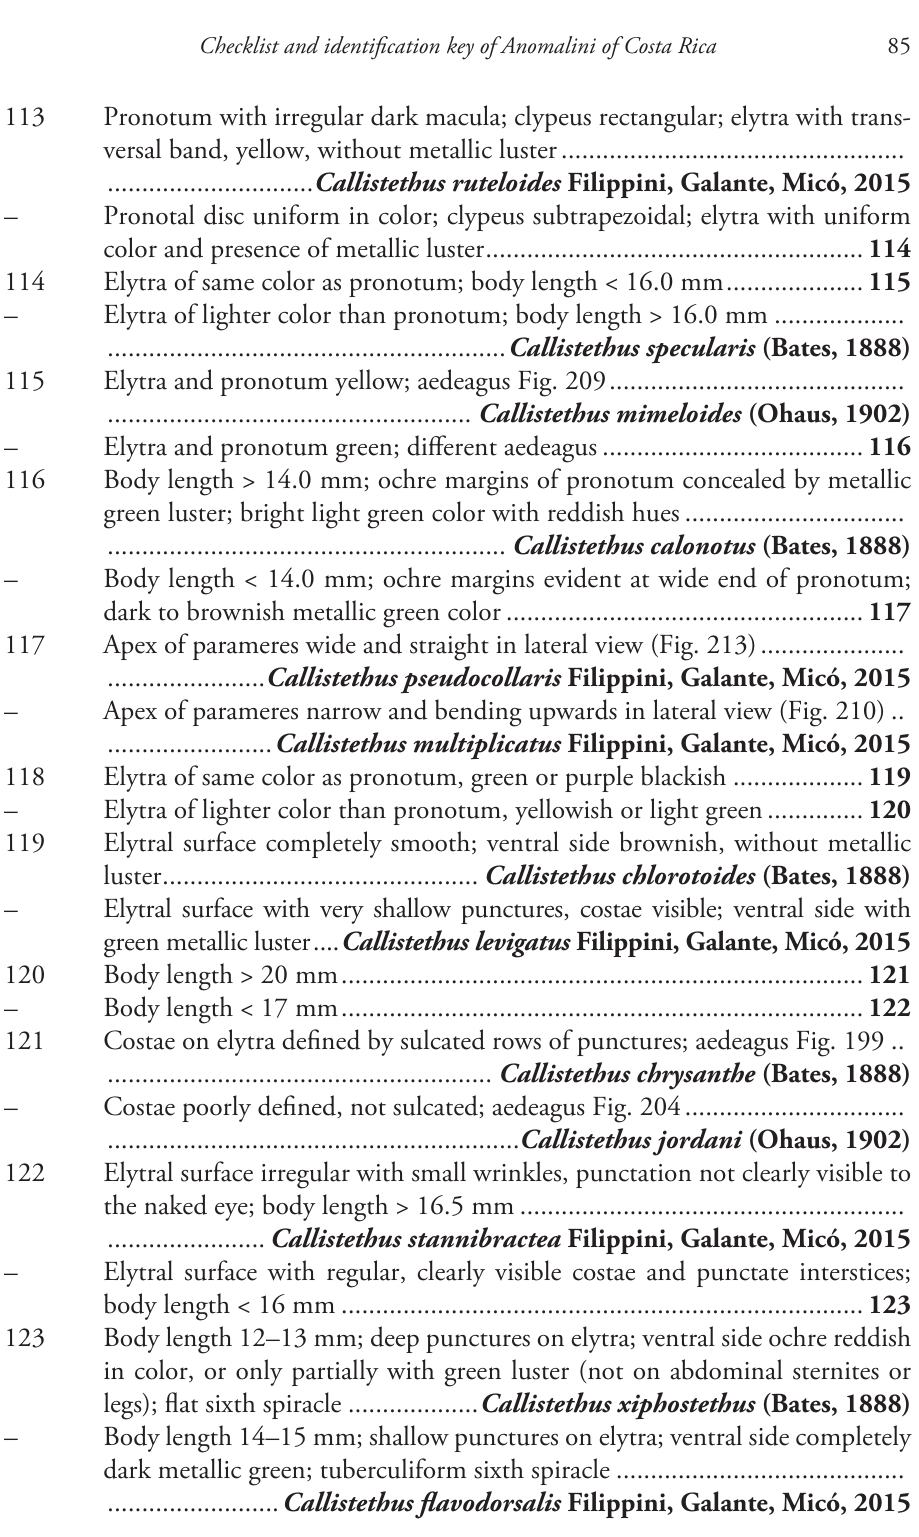
– Pronotal disc uniform in color; clypeus subtrapezoidal; elytra with uniform 114 – 115 – 116 Body length > 14.0 mm; ochre margins of pronotum concealed by metallic